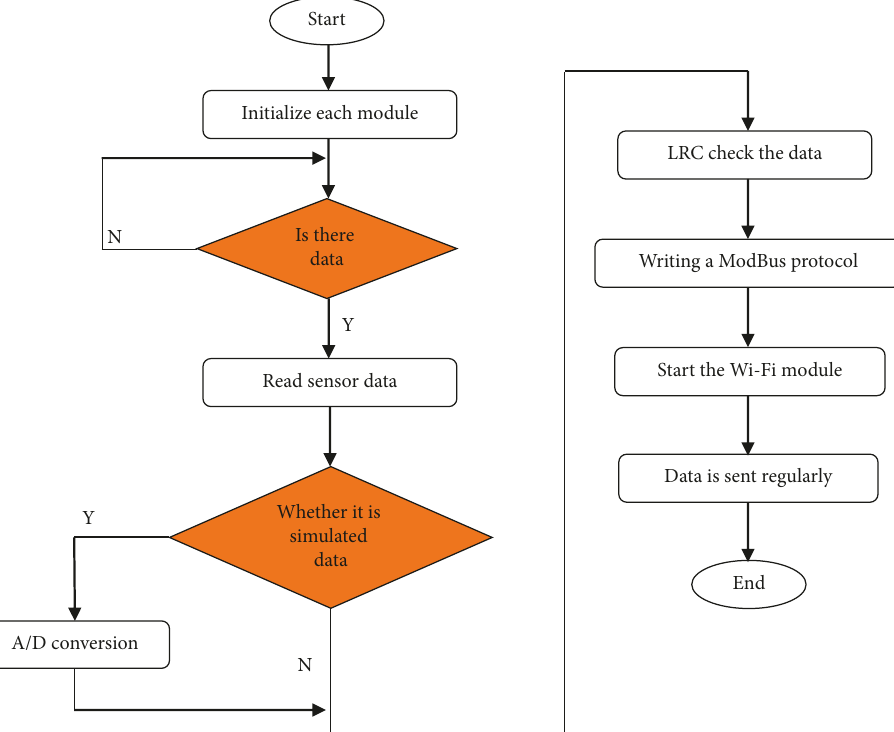
Figure 4: Software design flow chart of environment parameter collection